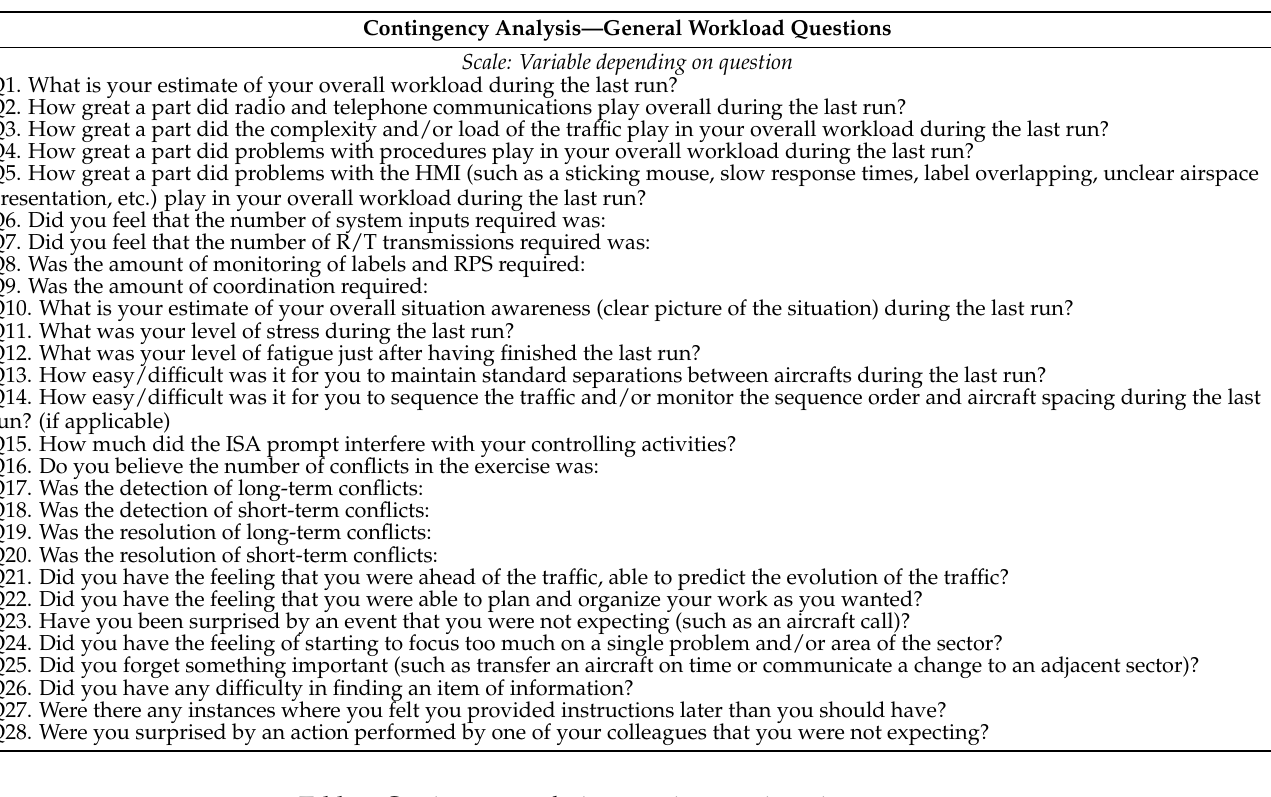
Table 7. Contingency analysis general workload questionnaire.